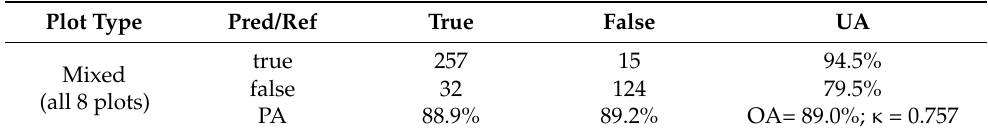
Table 7. The confusion matrix and performance metrics of the RF classification based on the test dataset comprising 8 forest plots.